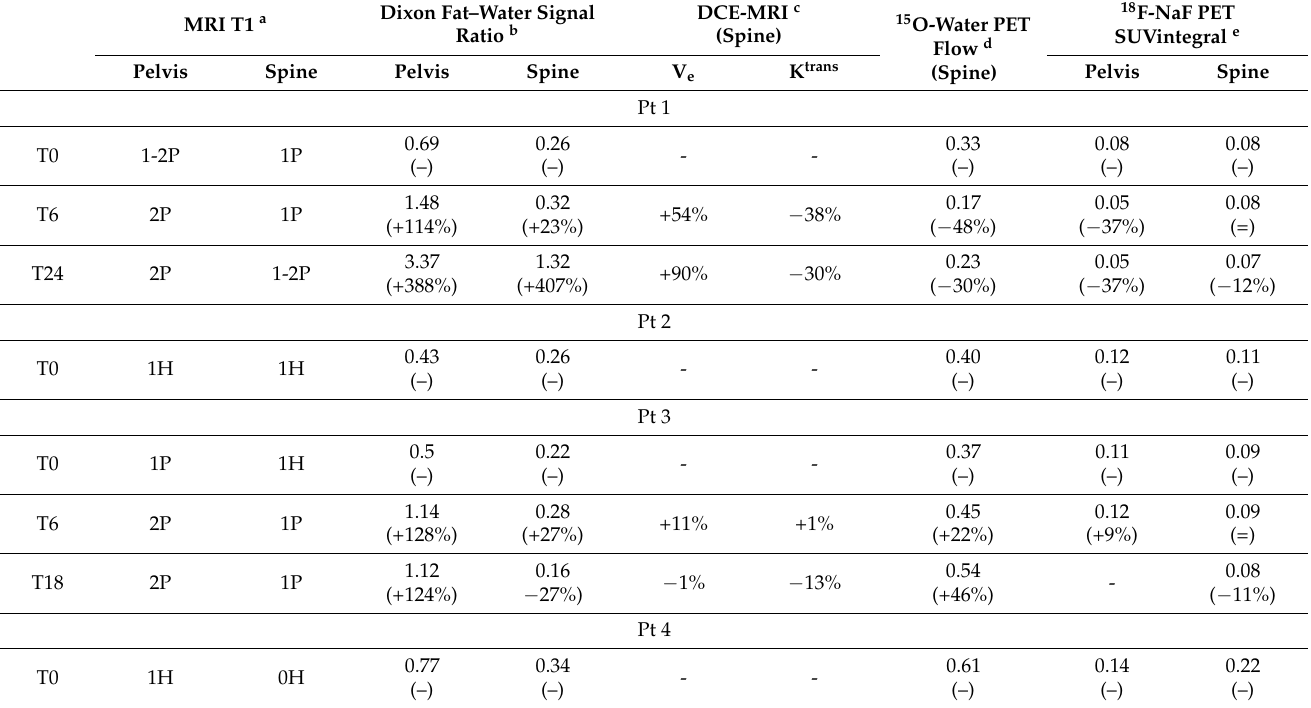
Table 4. Imaging